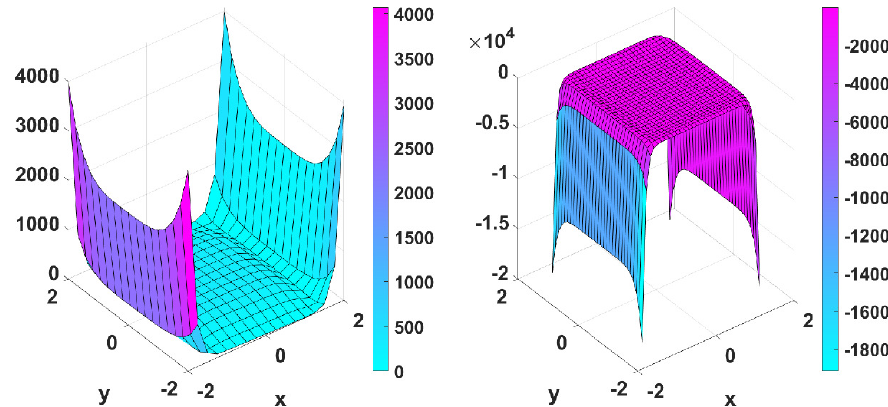
Figure 12. Graphical representations of f 3 ( Ψ 1 ( X )) and − f 3 ( Ψ 2 ( X )) Table 3. Information about the k -iteration associated with Figures 13 and 14.